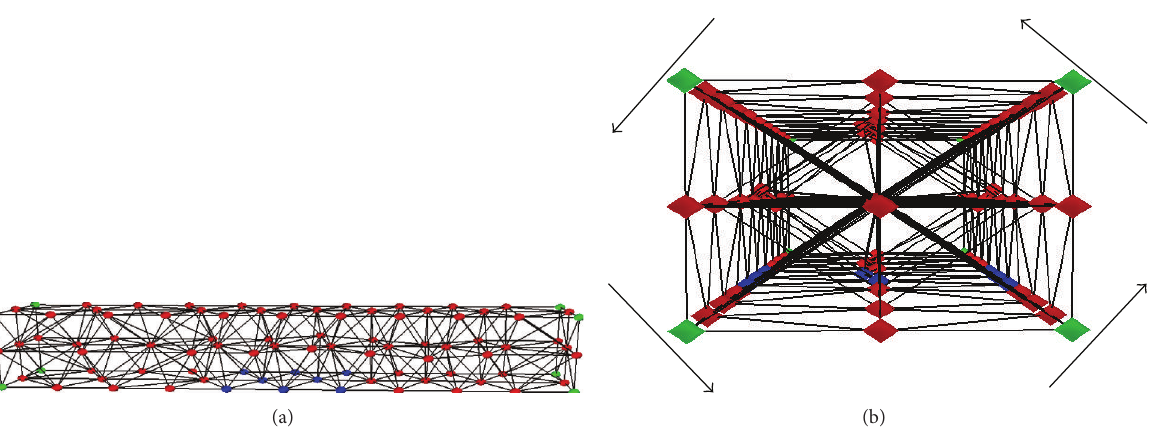
Figure 6: The beam mesh is constrained at the blue nodes and twisted at the green nodes. (a) Front view; (b) side view, which shows the force directions applied on each green node.